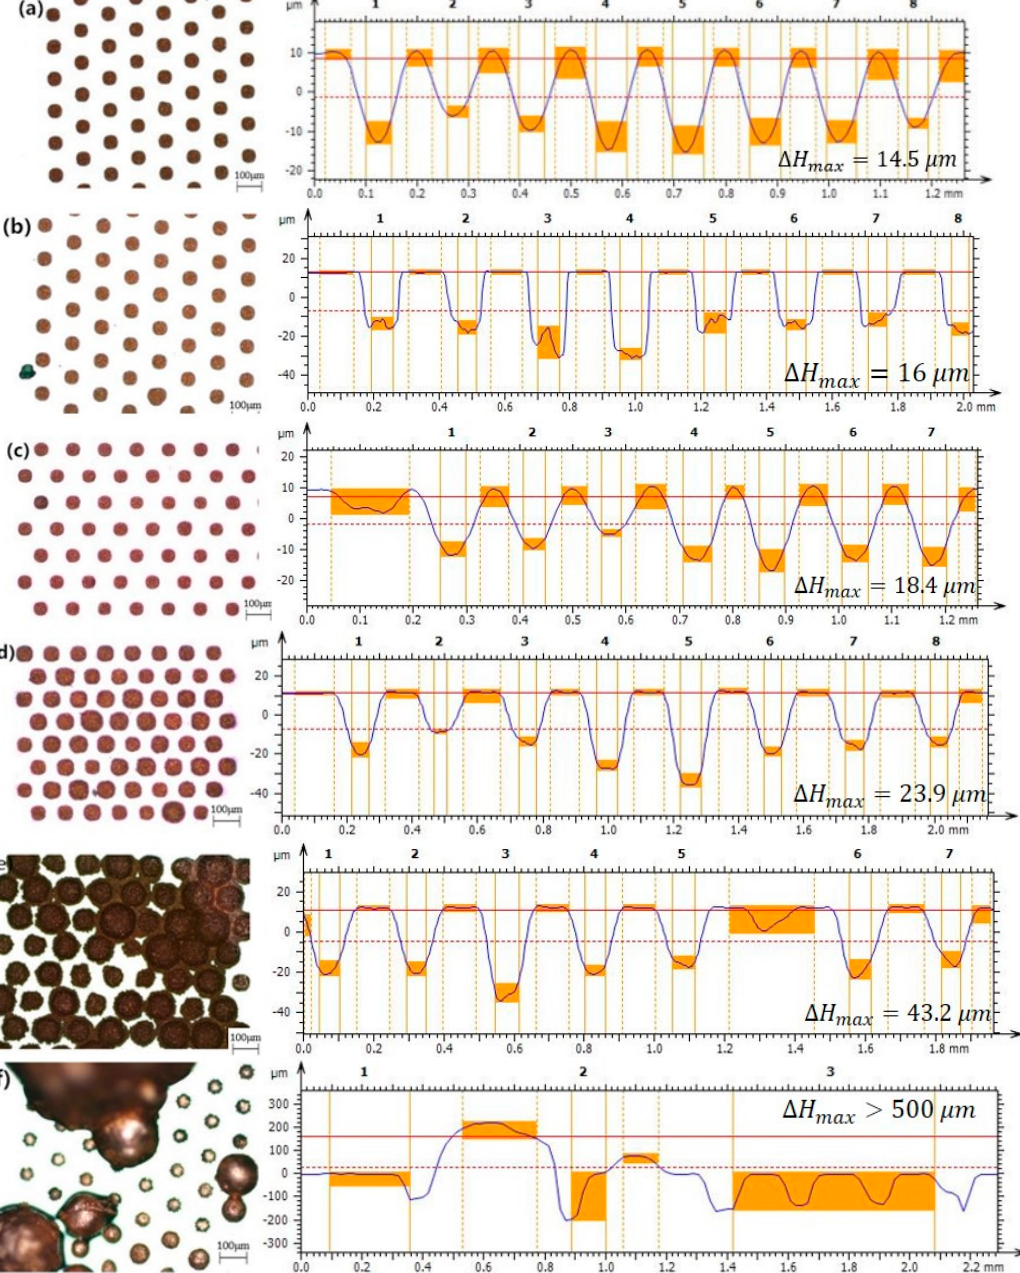
Figure 5. Top views and profile height diagram taken from the section displaying the greatest height difference under different current conditions using an optical microscope and a confocal displacement detector: ( a ) 0.5 A/dm 2 , ( b ) 1 A/dm 2 , ( c ) 1.25 A/dm 2 , ( d ) 1.5 A/dm 2 , ( e ) 1.75 A/dm 2 , and ( f ) 2 A/dm 2 .